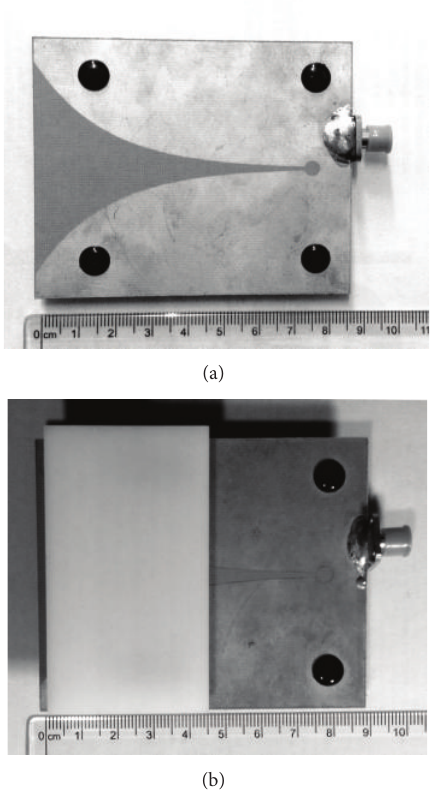
Figure 8: (a) Picture of the original antenna and (b) picture of the improved antenna.